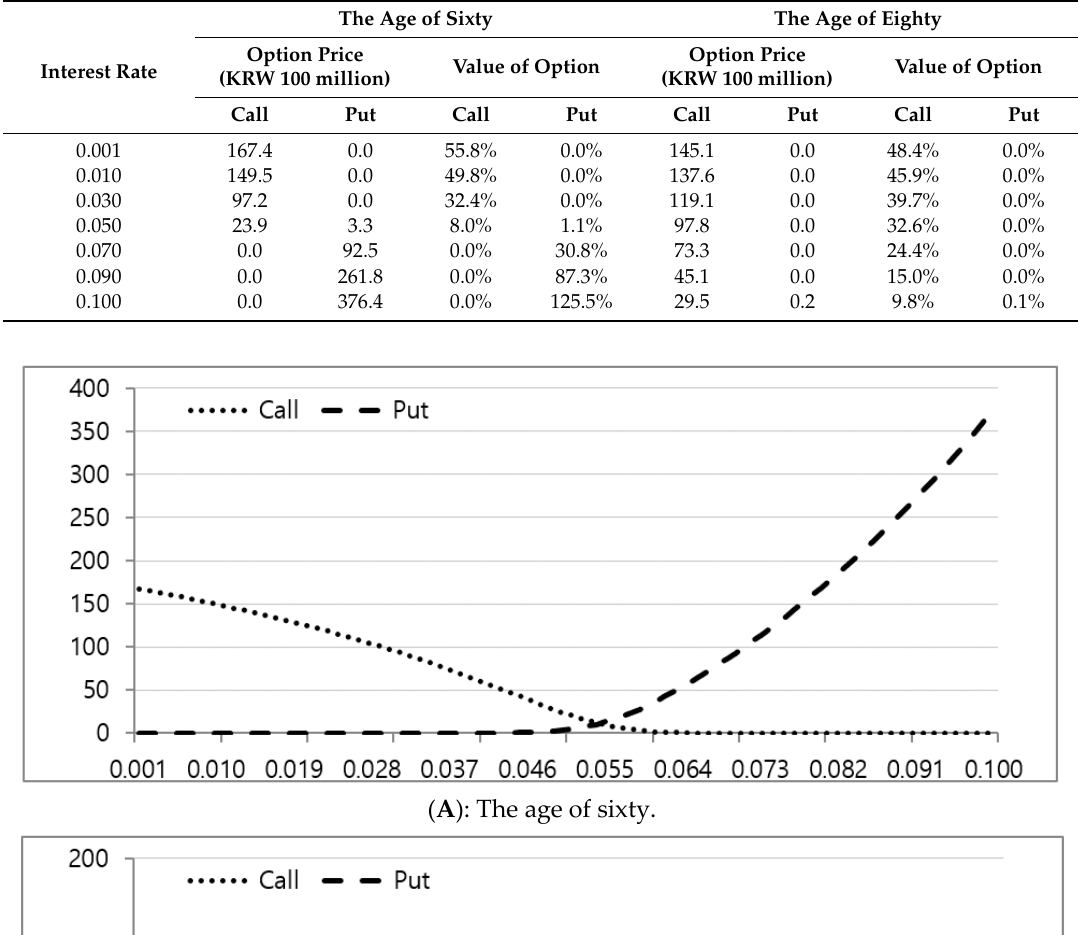
Table 4. Sensitivity analysis of the change of exercise price. This table presents the estimated total option value based on changes in the exercise price.